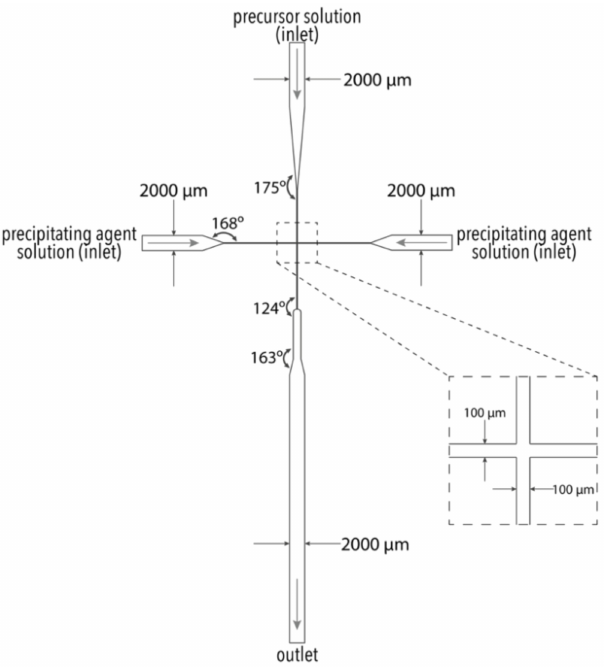
Figure 2. Configuration of the cross-junction channel within the middle